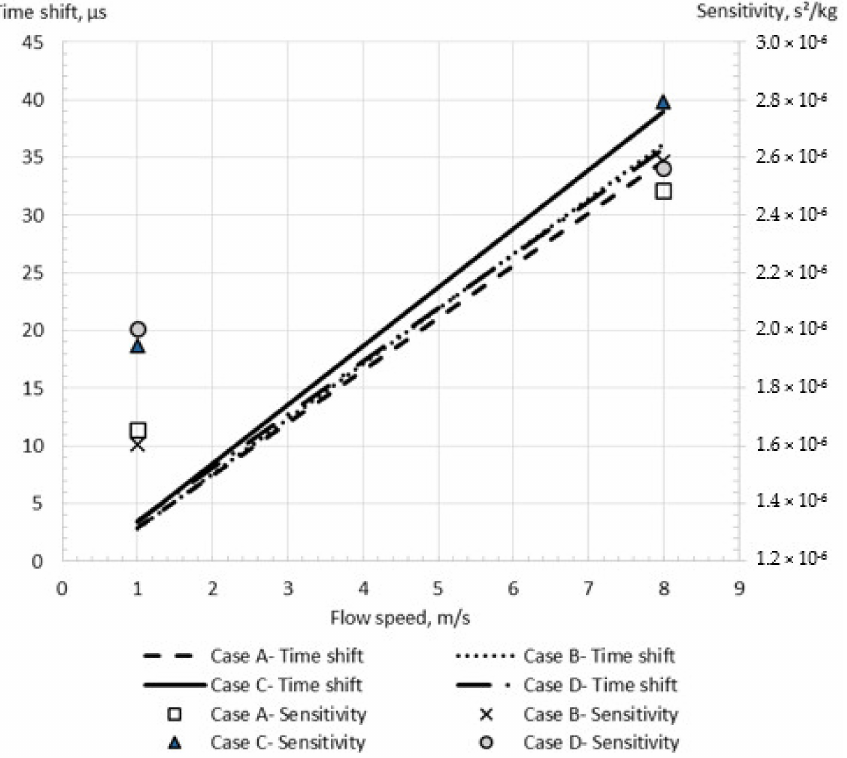
Figure 7. Simulation results for different geometrical simplifications for the shear stress turbulence